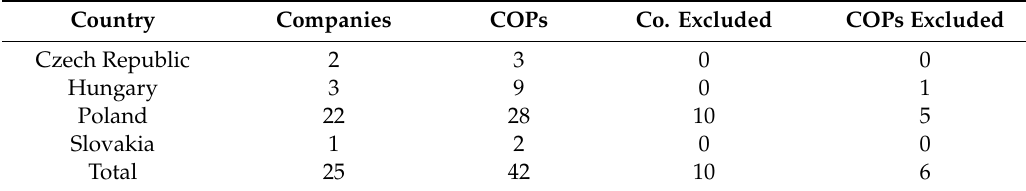
Table 1. Description of the dataset for the companies’ commitment analysis.